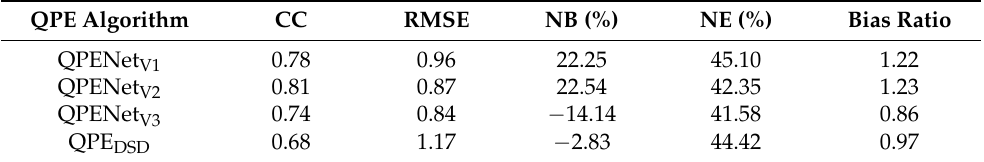
Table 6. The same as Table 5 except that the rainfall intensity is less than 5 mm · h − 1 ( R < 5 mm · h − 1 ).